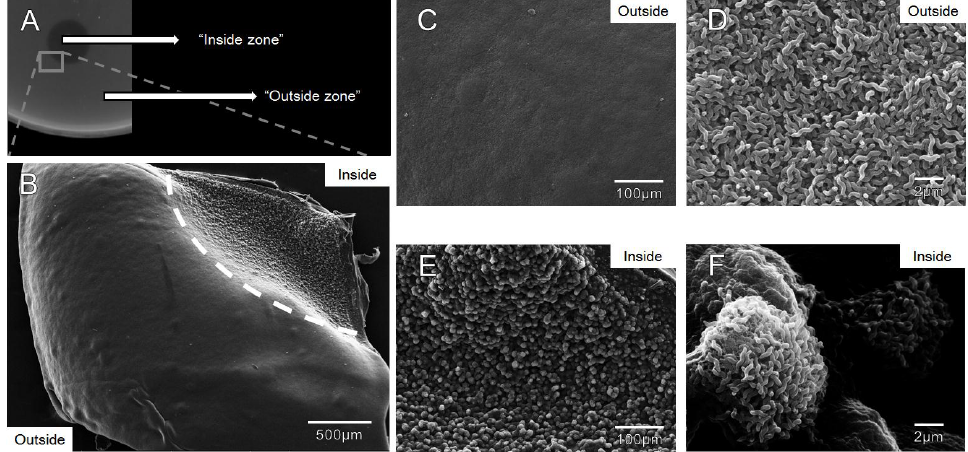
Figure 3. Scanning electron micrographs depicting C. jejuni 11168 growth in molten NZCYM agar at the interface where purified full-length Gp047 (0.9 mg/mL) was spotted. ( A ) An image of an excised agar slab where Gp047 was spotted on C. jejuni 11168 and the resulting clearance effect observed after 24 h (the grey box shows where the agar slab was excised); ( B ) A low magnification image those that were not exposed (remainder of the square), separated by a dotted white line; ( C and D )